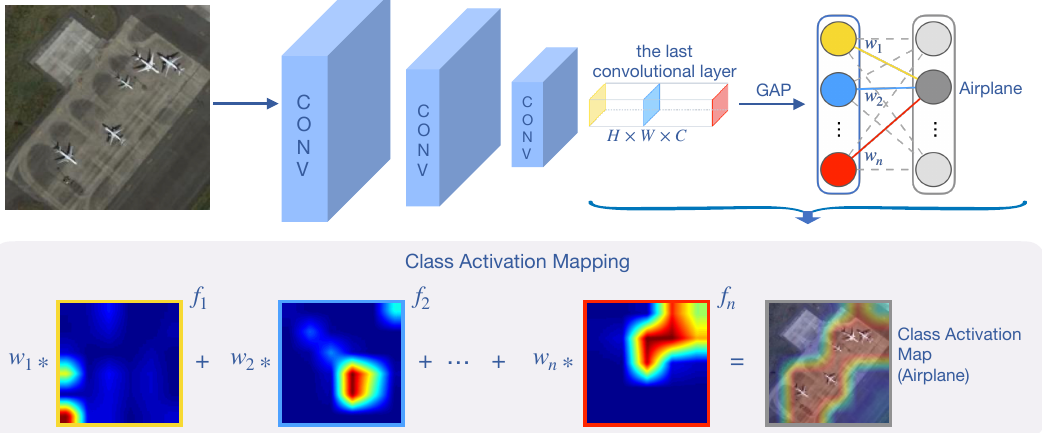
Figure 5. Class Activation Mapping: the predicted classification weight is mapped back to the feature maps generated from the last convolutional layer to compute the class activation maps (CAMs). The CAM highlights the discriminative regions of the corresponding